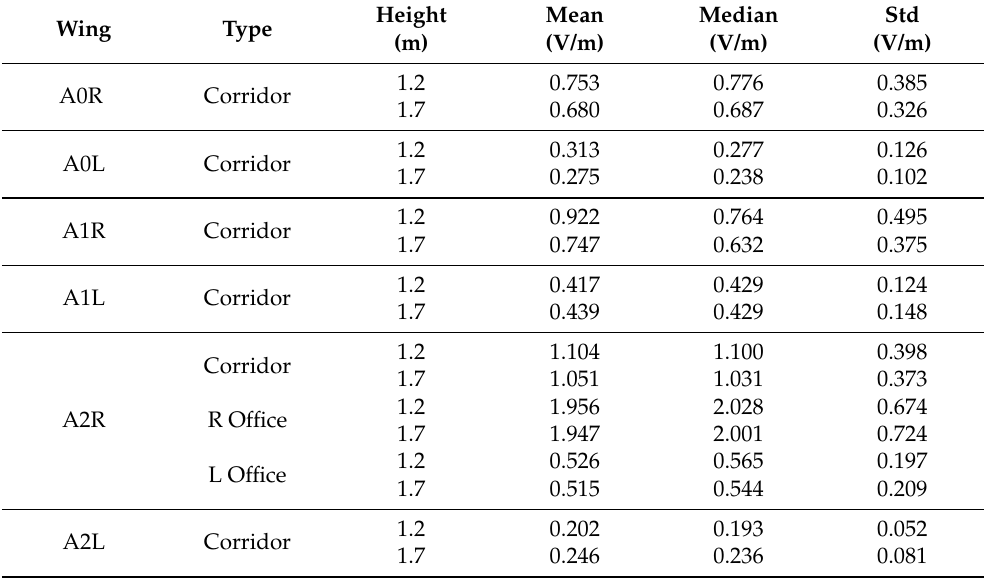
Table 2. Mean, median, and standard deviation of two height measurements for building